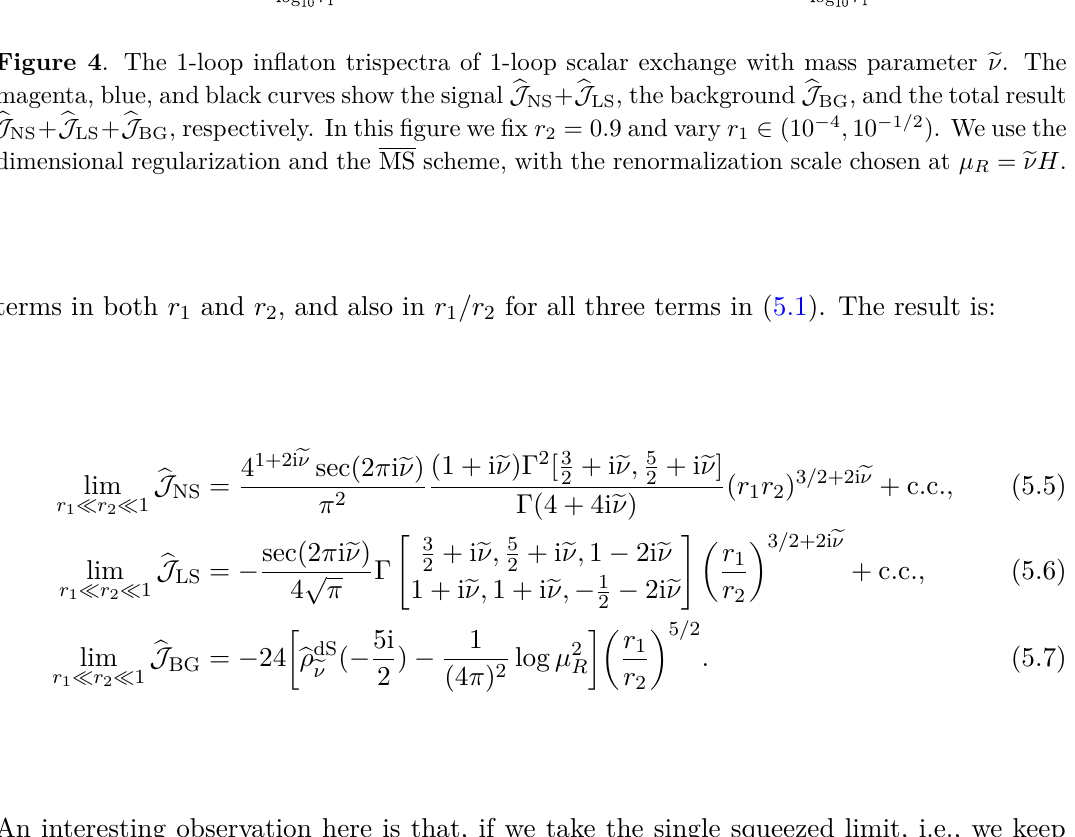
Figure 4 . The 1-loop inflaton trispectra of 1-loop scalar exchange with mass parameter magenta, blue, and black curves show the signal b J b J NS + b J LS + b J BG , respectively. In this figure we fix r 2 = 0 . 9 and vary r 1 ∈ (10 − 4 , 10 − 1 / 2 ) . We use the dimensional regularization and the MS scheme, with the renormalization scale chosen at µ